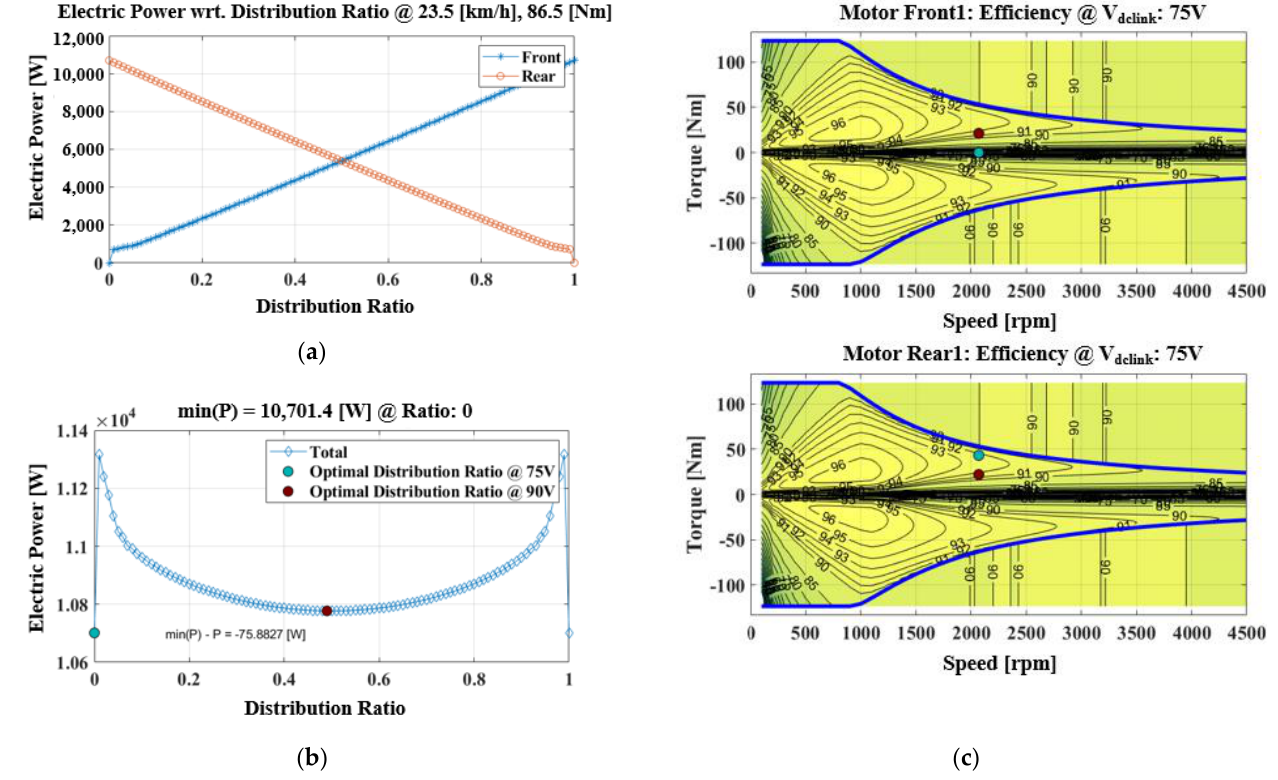
Figure 12. The difference of power consumption on optimal distribution with V dclink ; ( a ) The desired electric power of front and rear traction motor with respect to the distribution ratio, ( b ) Total electric power with respect to the distribution ratio, ( c ) Operating points of front and rear traction motor.